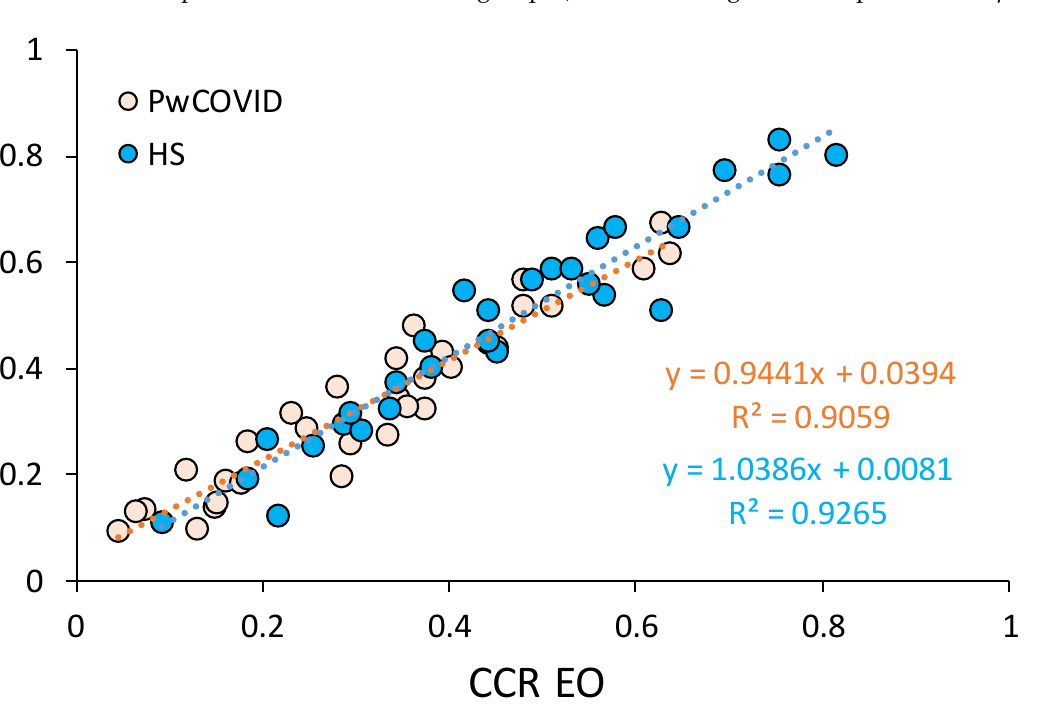
Figure 2. Relationship between CCR EO and CCR EC in PwCOVID and HS in stabilometric assess- ment. Subjects were instructed to count backwards in threes; number of total subtractions and errors were recorded to calculate each CCR, separately for each visual condition. Orange dots represent PwCOVID and blue dots HS. The relationship between CCR in the different visual conditions shows a linear correlation and the slopes of the fit line across each group are similar (orange and blue line for PwCOVID and HS, respectively). Abbreviations: PwCOVID, people with COVID-19; HS, healthy subjects; CCR, correct cognitive response; EO, eyes open; EC, eyes closed.